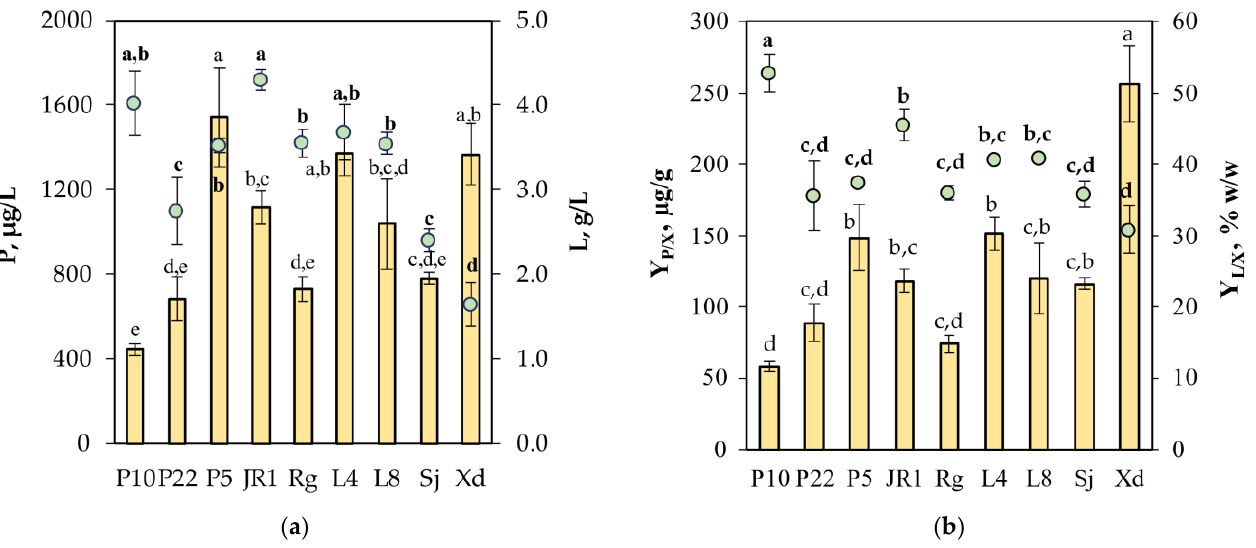
Figure 2. Simultaneous production of lipids and carotenoids by oleaginous yeast. ( a ) Carotenoids (P) and lipid production (L). ( b ) Carotenoids yield per biomass (Y P/X ) and lipid content per biomass (Y L/X ). Carotenoids (yellow bar), lipids (green circle). Superscript letters a, b, c, d, and e indicate significant differences at p < 0.05.